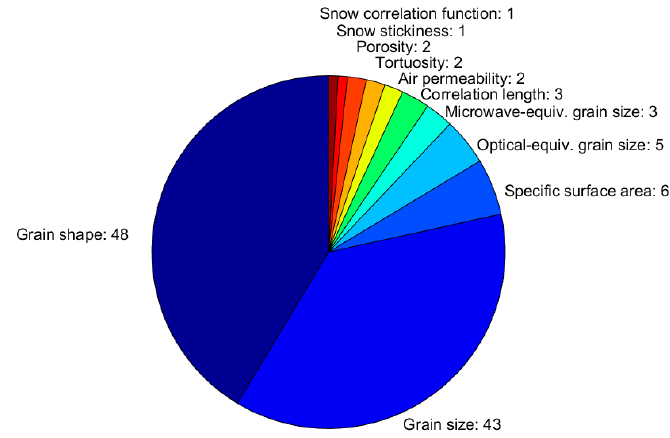
Figure 8. Measured snow microphysical properties. The width of each slice corresponds to the fraction each snow microphysical property has, relative to the total number of reported microphysical properties (i.e., the sum of the numbers given in the figure). The optical- and microwave-equivalent grain size are measured by five and three respondents, respectively (optical-equivalent grain size from Finland, France, Romania, and Switzerland, and the microwave-equivalent grain size from Finland, France, and the U.K.).